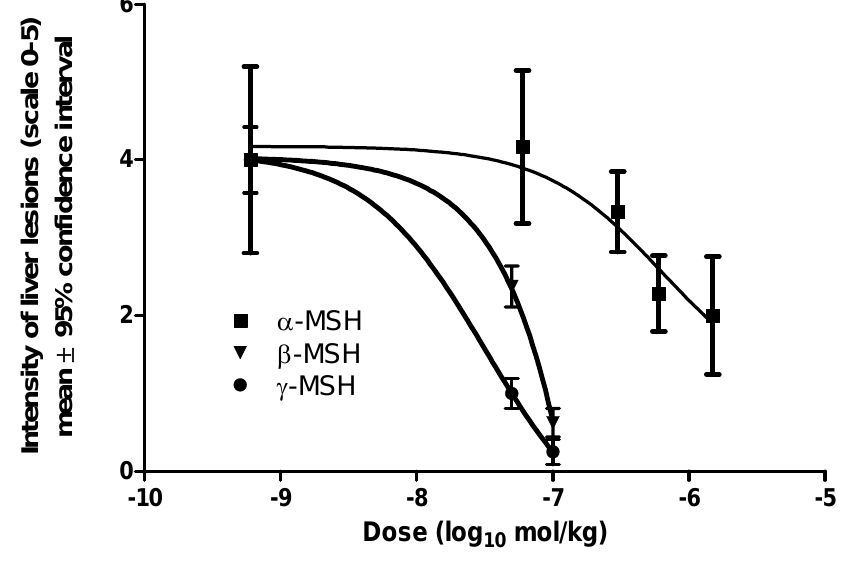
Figure 1. Dose-response curve for α -, β -, and γ -MSH in a prevention of liver necrosis produced by acetaminophen (150 mg/kg